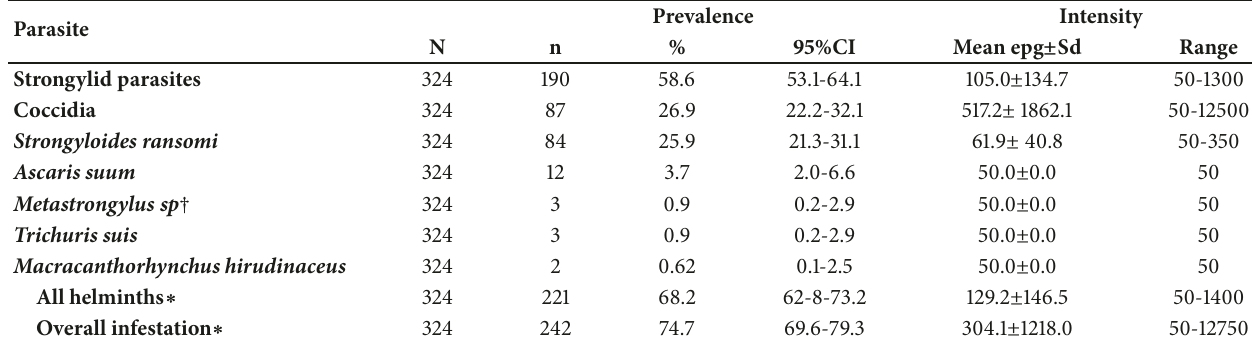
Table 1: Prevalence and intensity of internal parasites of pigs in Bamboutos, Cameroon.